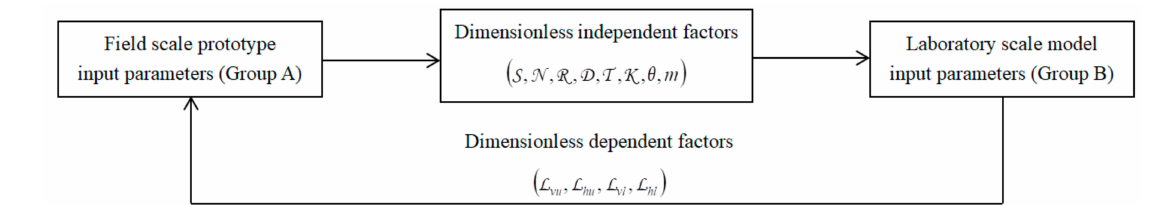
Figure 6. Flow chart of the strategies for relating field scale PHFs to laboratory scale